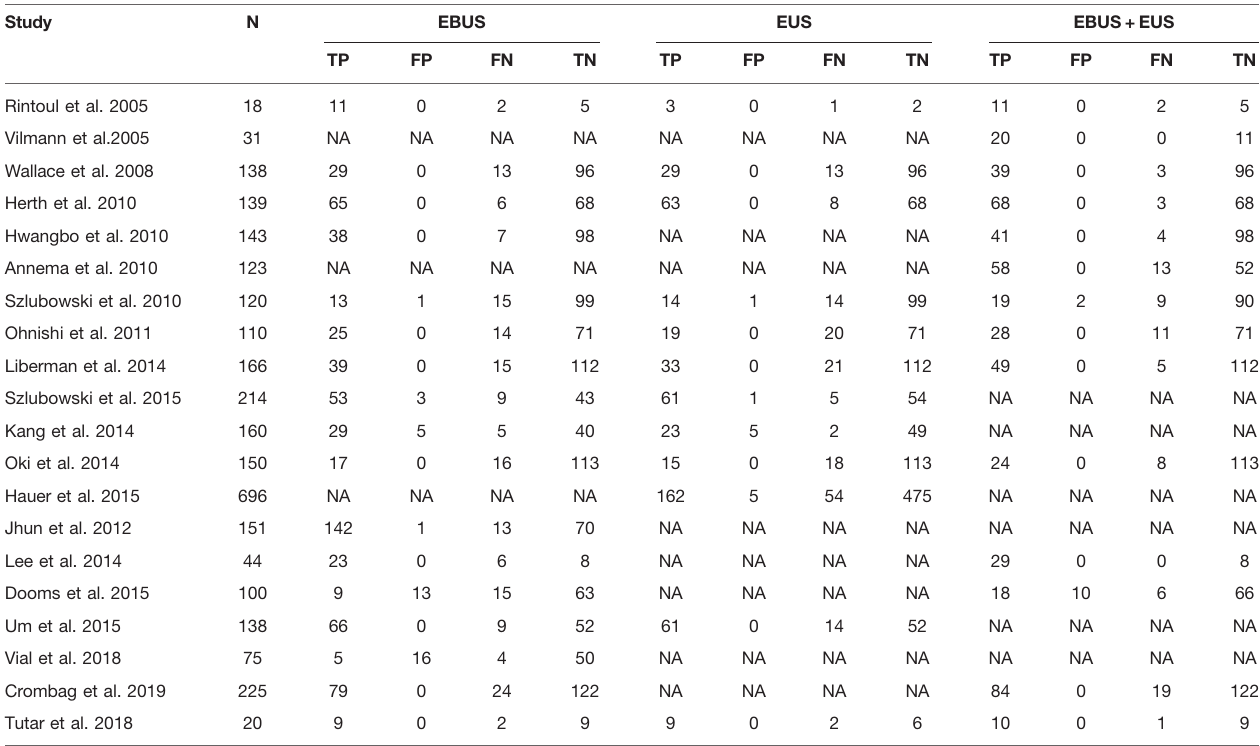
TABLE 2 | Accuracy in detecting mediastinal nodal metastases across included studies Study